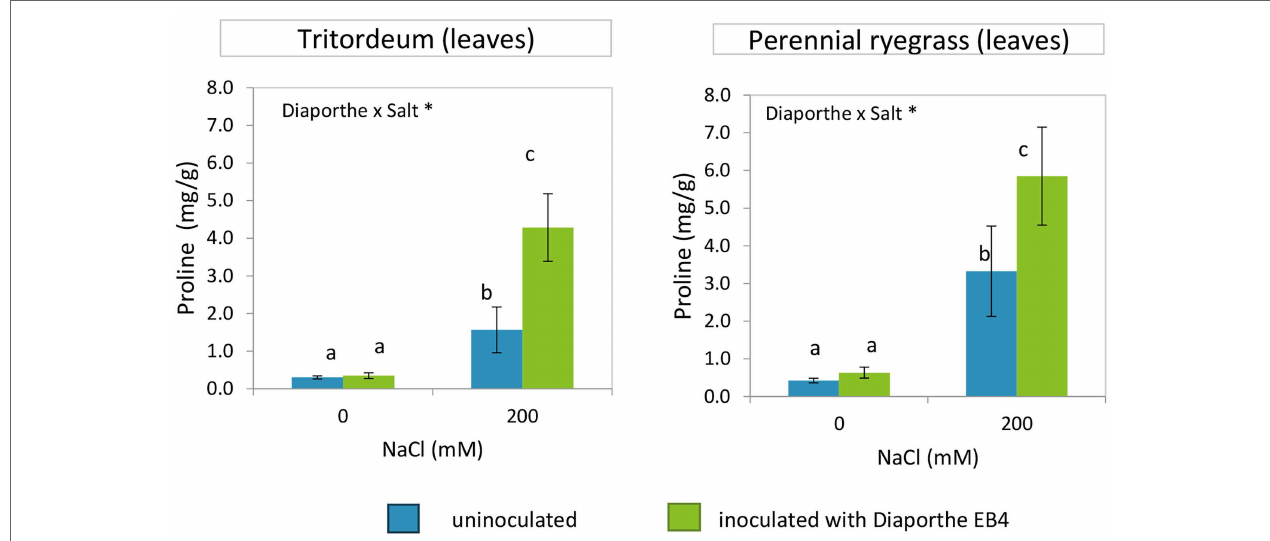
FIGURE 4 | Proline content in leaves of tritordeum and perennial ryegrass plants not inoculated ( BLUE ) or inoculated with Diaporthe EB4 ( GREEN ), at two different salinity treatments (0 and 200 mM NaCl). Values are means ± SD ( n = 6). When the interaction [ Diaporthe inoculation × salinity] was significant, different means are indicated with different letters (Tukey test p < 0.05). Significant effects of “ Diaporthe inoculation” and/or “salinity” are indicated as * p <